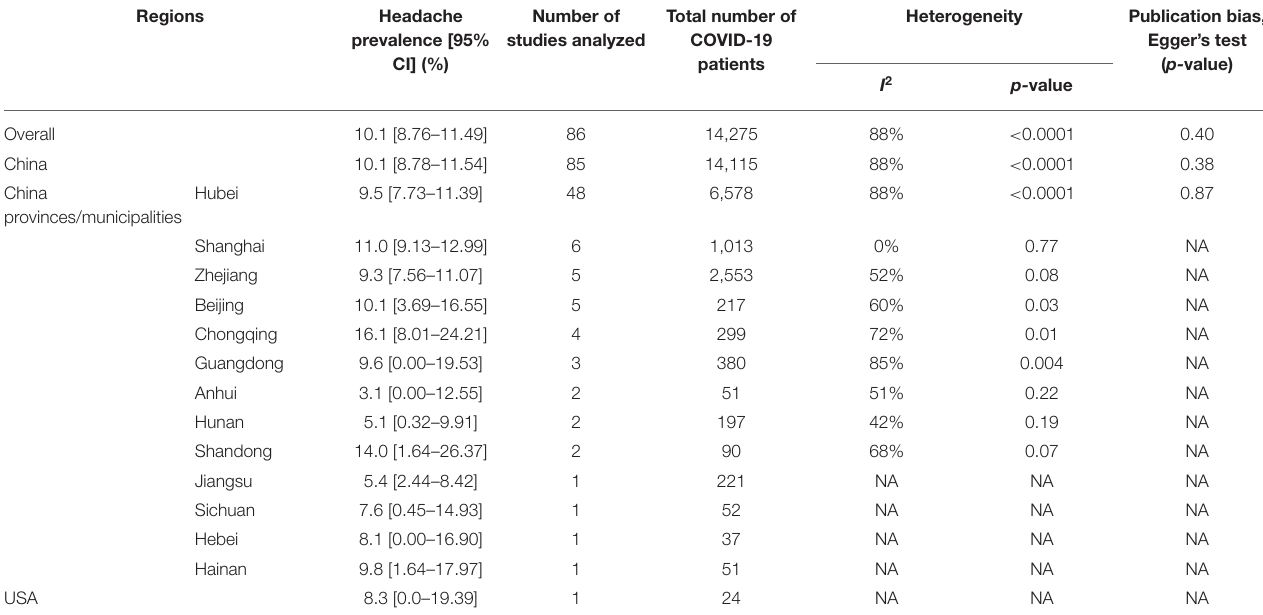
TABLE 1 | Pooled prevalence of headache in COVID-19 patients from different regions.